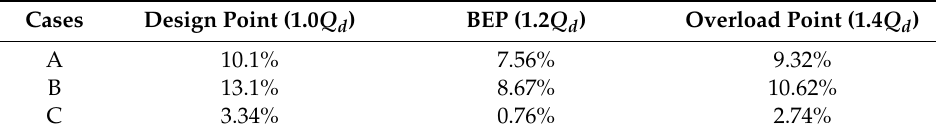
Table 4. Improvement of optimized cases with respect to the baseline